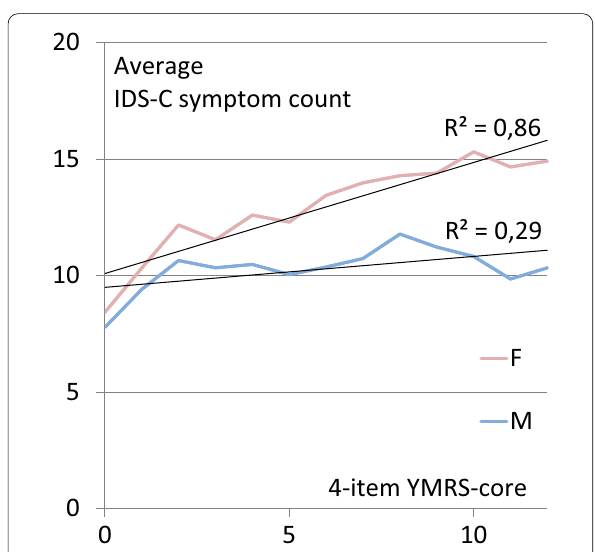
Fig. 4 Average IDS-C-Score by 4 item YMRS CORE SCORE (male vs